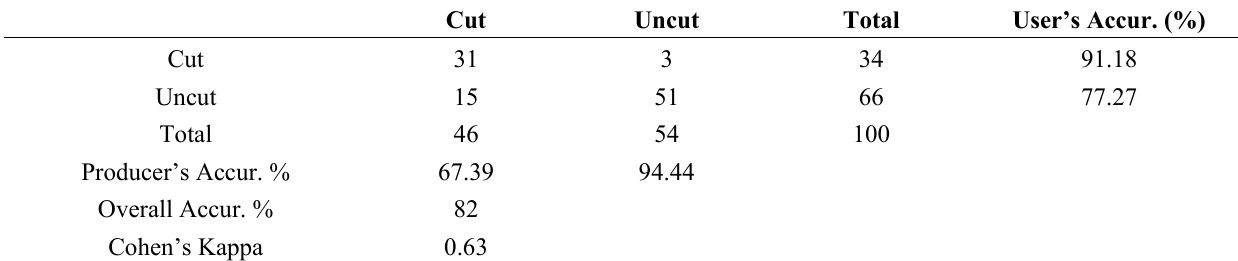
Producer’s Accur.